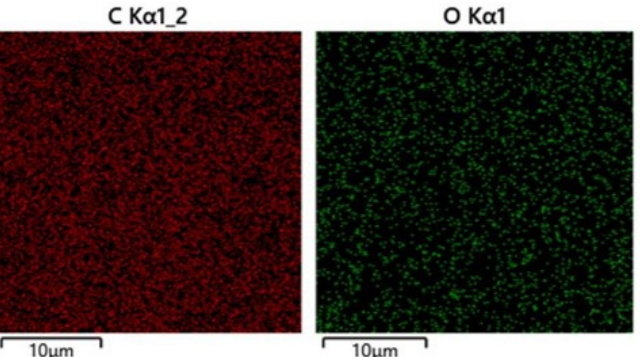
Figure 4. EDX maps of carbon (C) and oxygen (O) on the bulk 3-µm grating inside the PET sample.